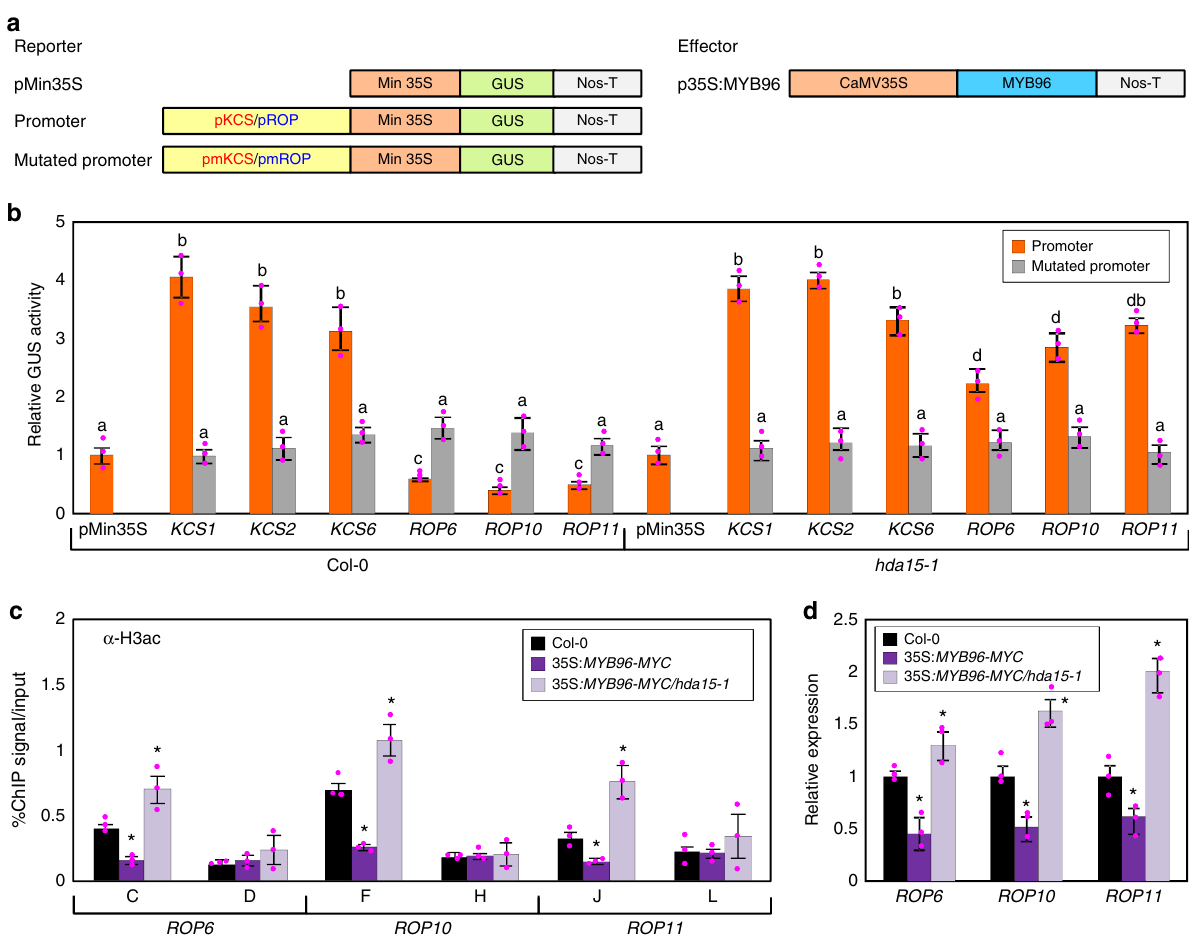
Fig. 7 MYB96 represses expression of ROP genes in an HDA15-dependent manner. a Schematic representation of reporter and effector constructs. The pmKCS and pmROP constructs contain mutated core cis -elements (Supplementary Table 3), which impair recognition of R2R3-type MYB DNA-binding domain, on the KCS and ROP gene promoters, respectively. pMin35S, minimal 35S promoter, CaMV Cauli fl ower mosaic virus, Nos-T nopaline synthase terminator. b Transient expression assays using Arabidopsis protoplasts. The recombinant reporter and effector constructs were coexpressed transiently in Arabidopsis protoplasts, and GUS activity was determined fl uorimetrically. Luciferase gene expression was used to normalize GUS activity. The normalized values in control protoplasts were set to 1 and represented as relative activation. Three independent measurements were averaged. Different letters represent a signi fi cant difference at P < 0.05 (one-way analysis of variance with Fisher ’ s post hoc test). Bars indicate the standard error of the mean. c H3ac levels in 35S: MYB96-MYC/hda15-1 . Two-week-old seedlings grown under long days were used to perform chromatin immunoprecipitation (ChIP) using anti-H3ac antibody. The indicated genomic regions (see Fig. 5) were analyzed by ChIP-quantitative PCR. Biological triplicates were averaged, and statistically signi fi cant differences between the wild-type and transgenic plants (Student ’ s t test, * P < 0.05) are indicated by asterisks. d Expression of ROP genes in 35S: MYB96-MYC/hda15-1 . Source data are provided as a Source Data fi